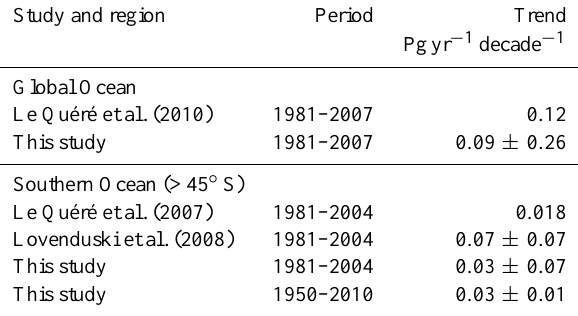
Table 3. Reduction in the net CO 2 flux due to climate change, over various regions and previous modelling studies in comparison to this work. Where applicable, trends are shown with adjusted confi- dence intervals. The results from this work come from the 1871 to 2010 simulation using 20CR winds and a constant GM coefficient.